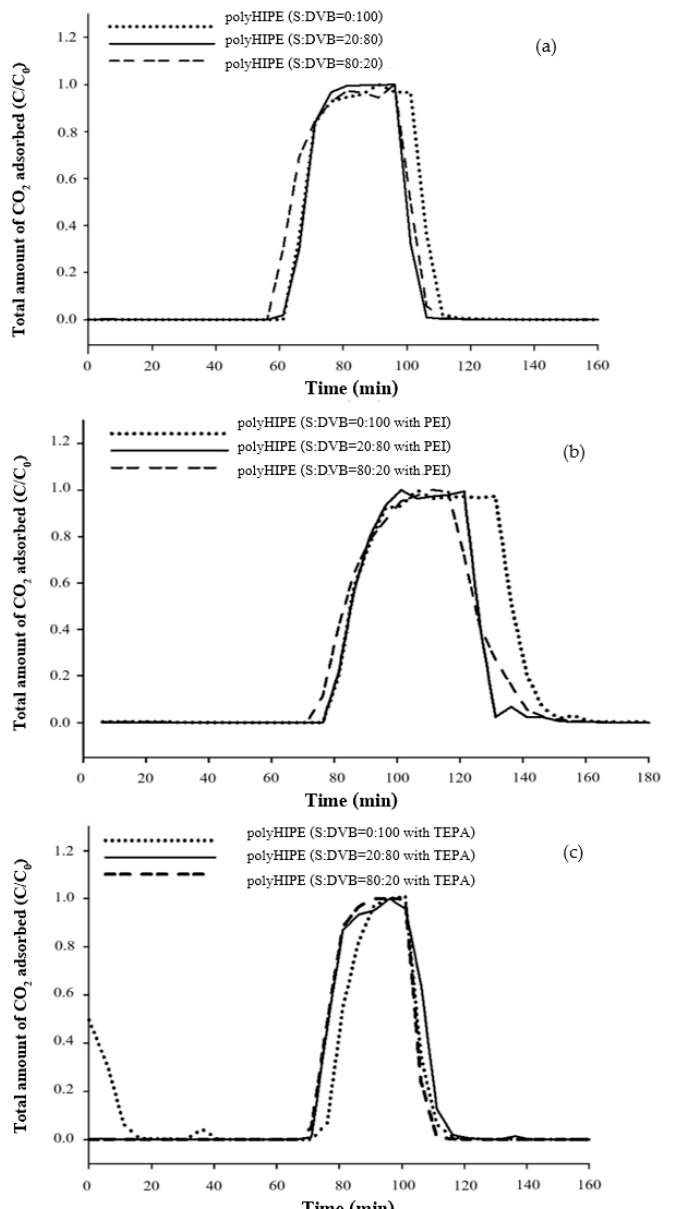
Figure 6. Comparison of the CO 2 breakthrough curve of ( a ) poly(S/DVB)HIPEs filled with different ratio of S/DVB, ( b ) modified poly(S/DVB)HIPEs with PEI and ( c ) modified poly(S/DVB) HIPEs with TEPA.